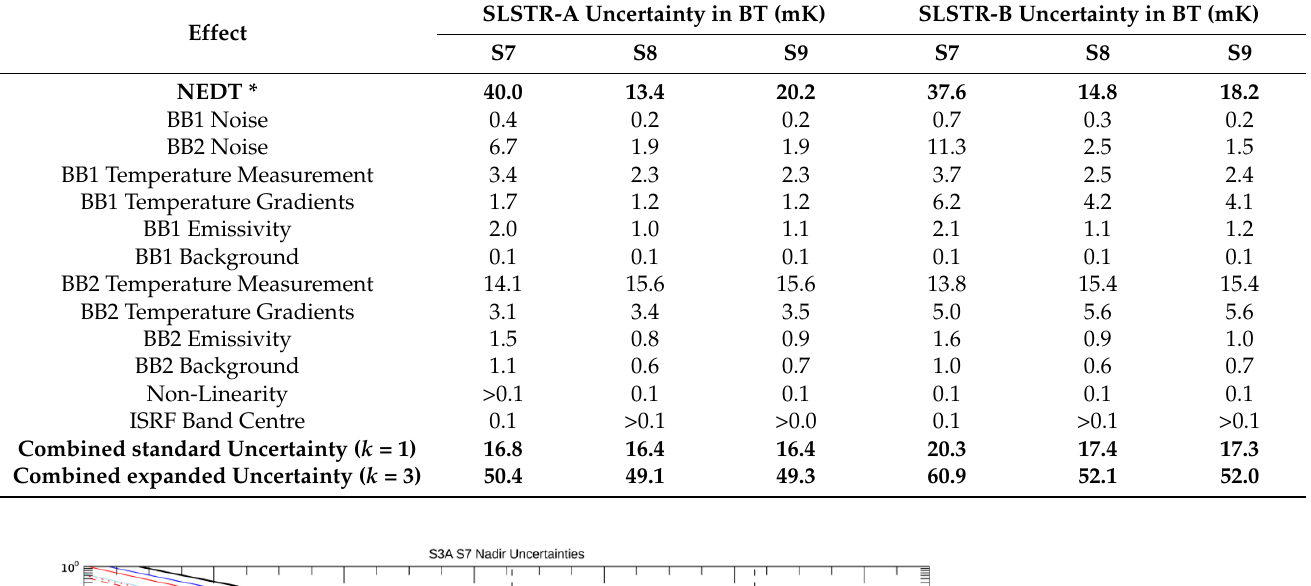
Table 10. Breakdown of uncertainty budget expressed as BT in milli-kelvin for SLSTR IR Calibration for a reference scene temperature at 270 K. * Because the Earth scene noise (NEDT) is assumed to be purely random, it is not included in the combined radiometric uncertainty of the radiometric calibration.